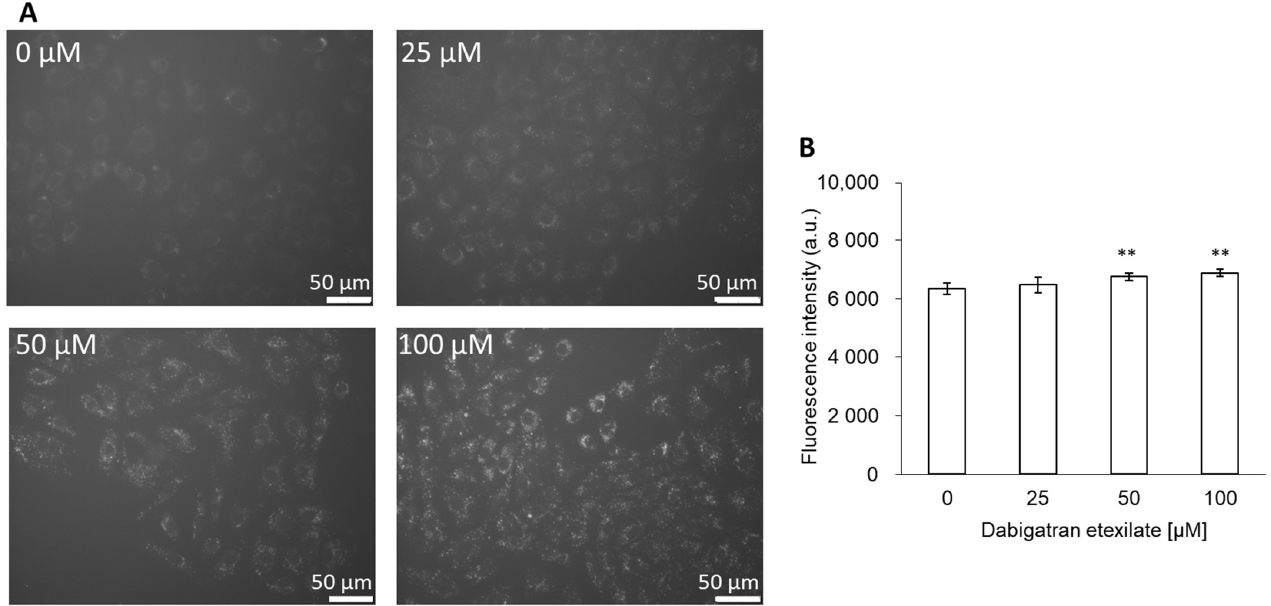
Figure 3. The fluorescence intensity of DPPP. ( A ) Fluorescent microscopy utilized to assess cellular uptake of DPPP. ( B ) Data are expressed as means ± SD (n = 10). The sample size is the number of cells in the analyzed images. Ex = 340–390 nm and Em = 420 nm. **p<0.01.